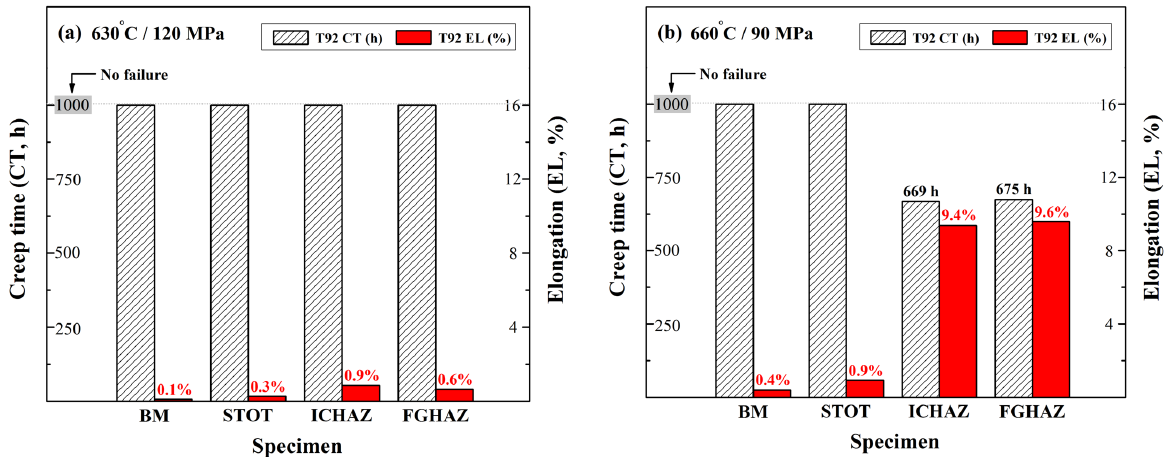
◦ C/120 MPa; and ( b ) 660 ◦ C/90